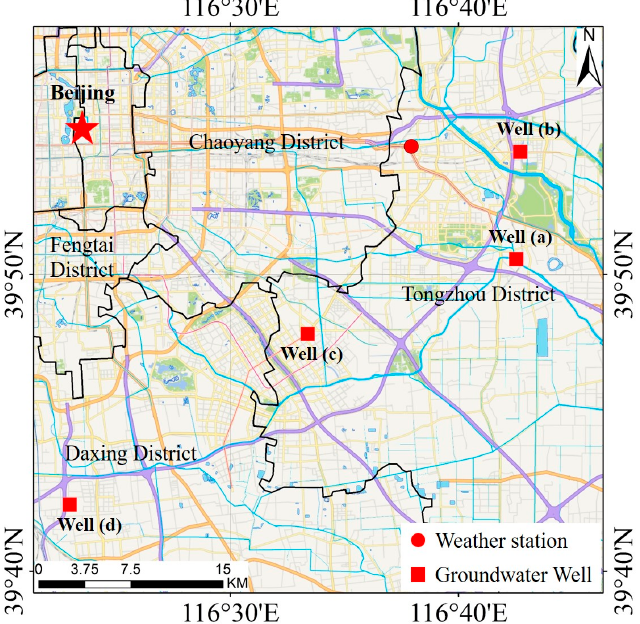
Figure 9. The vector map of Beijing. The red star represents that it is China’s capital. The red dot is the Beiyuan Street Weather Monitoring Station, and the red square is the groundwater burial depth monitoring station.